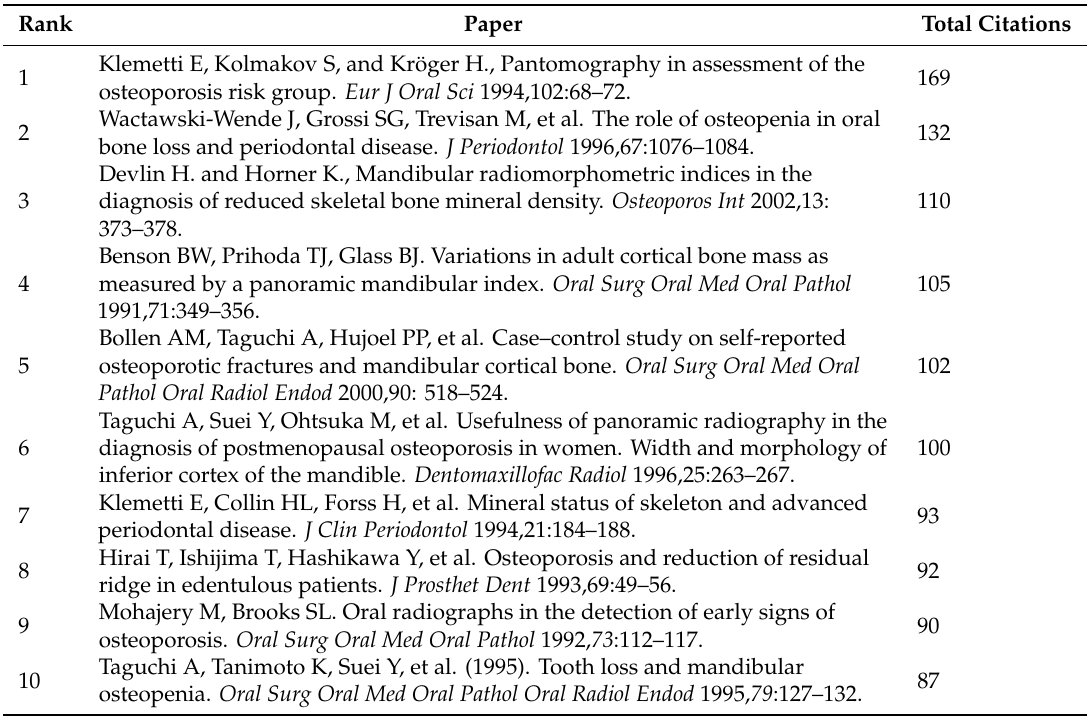
Table 2. Top ten most cited